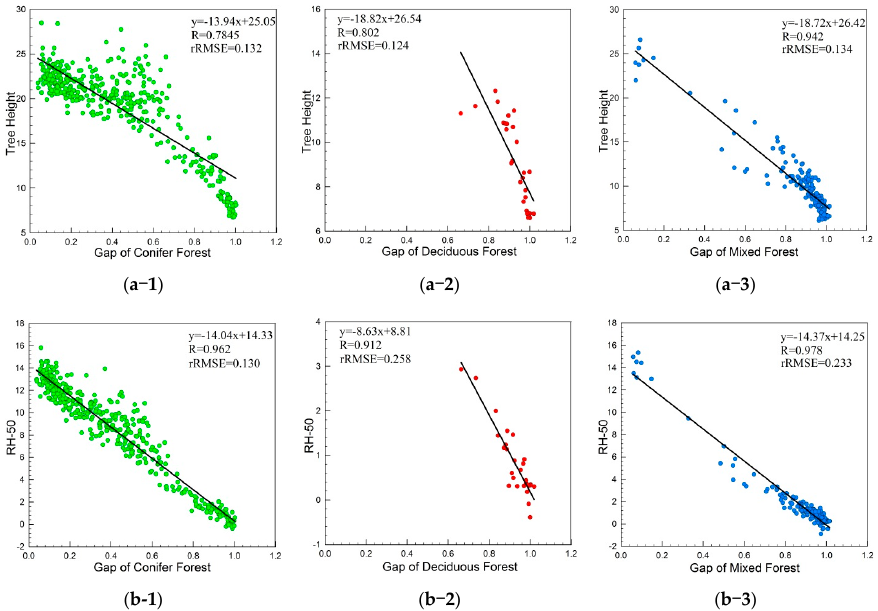
Figure 5. Relationship between tree height and gap fraction directly derived from the LVIS data for three kinds of forests in Howland. ( a-1 ), ( a-2 ), and ( a-3 ) represent the relationship between the tree height and gap of the conifer, deciduous, and mixed forests, respectively; ( b-1 ), ( b-2 ), and ( b-3 ) represent the relationship between RH-50 and the gap of the conifer, deciduous, and mixed forest, respectively.